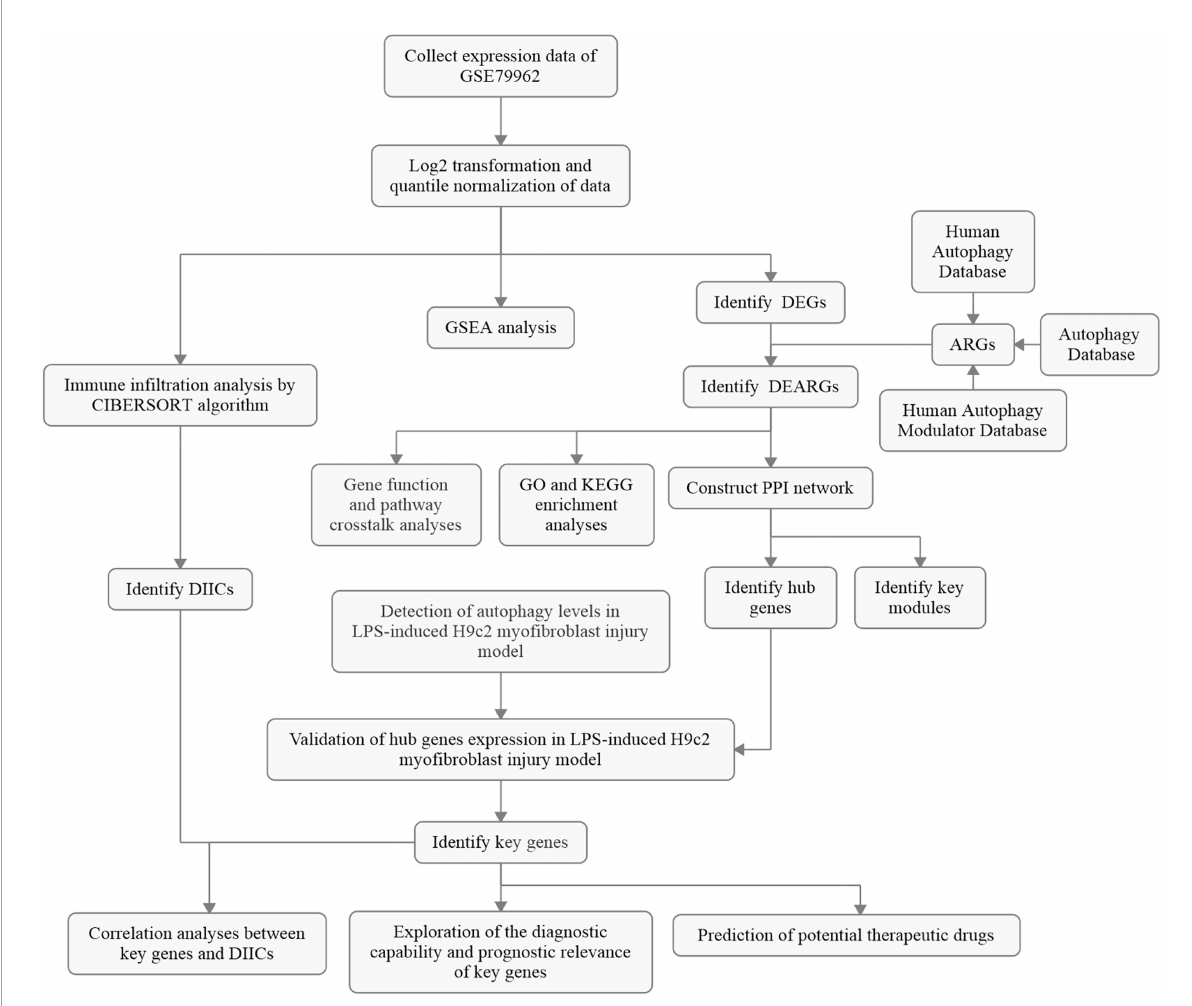
FIGURE1 The overall protocol of this study. DEG, differentially expressed genes; ARG, autophagy-related gene; DEARG, differentially expressed ARG; GO, Gene Ontology; KEGG, Kyoto Encyclopedia of Genes and Genomes; PPI, protein–protein interaction; DIIC, differentially infiltrating immune cell; LPS,